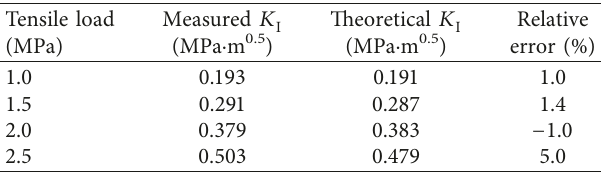
Table 1: The comparison between the measured values and the- oretical values of K Tensile load (MPa)